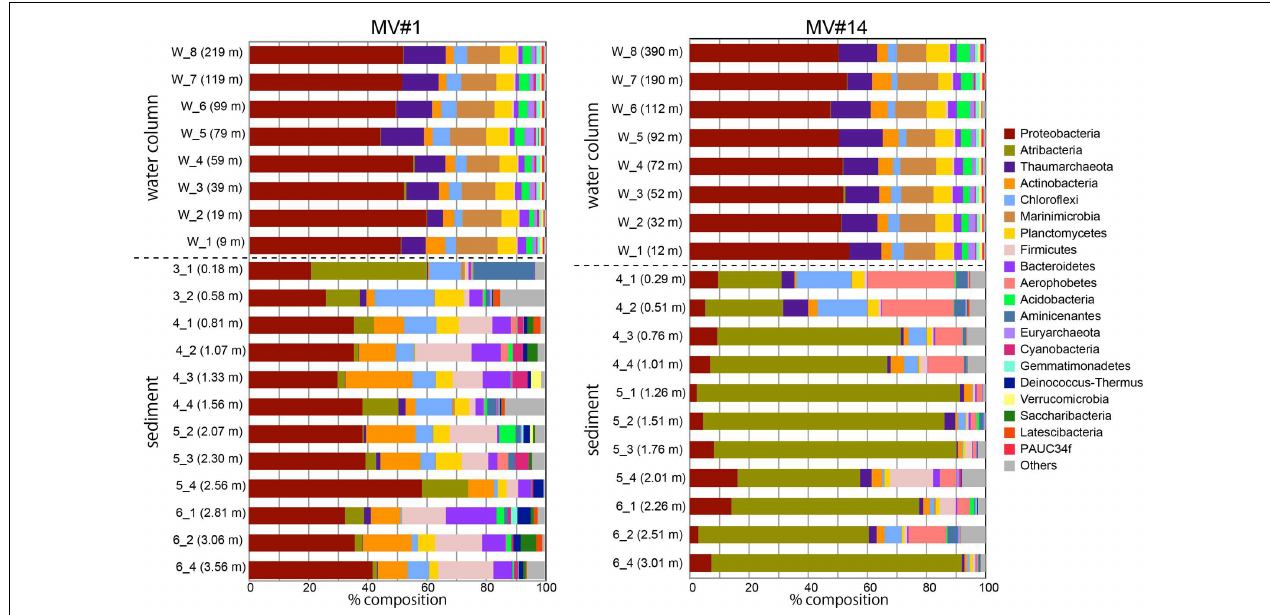
FIGURE 4 | Microbial community composition in the sediment and overlying seawater at two SMVs using phylum-level classification. Only the top 20 phyla are shown. Numbers in parentheses show the water column depth (meters above the SMV summit) for water samples (labels that start with “w”) and depth in sediment for sediment samples (labels that start with